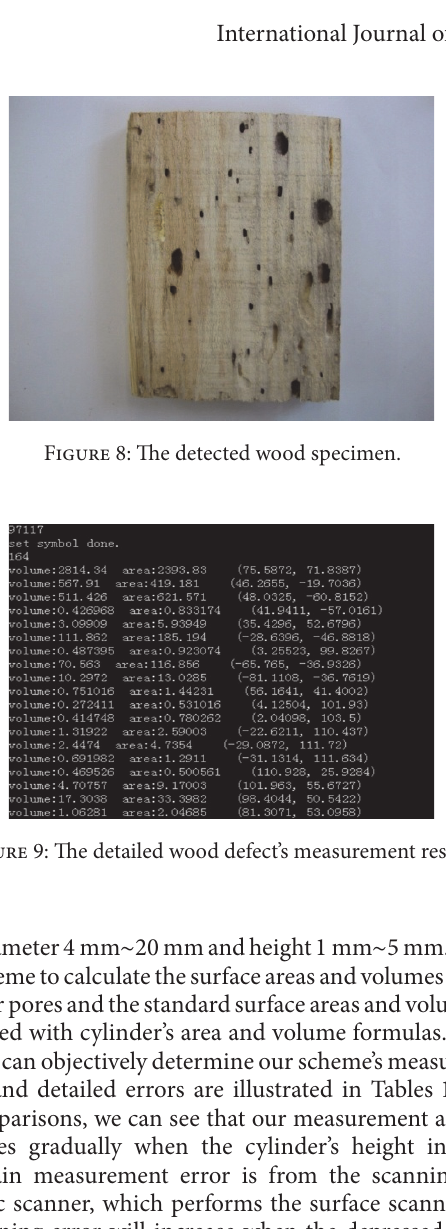
Figure 6: A defect point is extended into a purple regular hexagon PQRSNT .